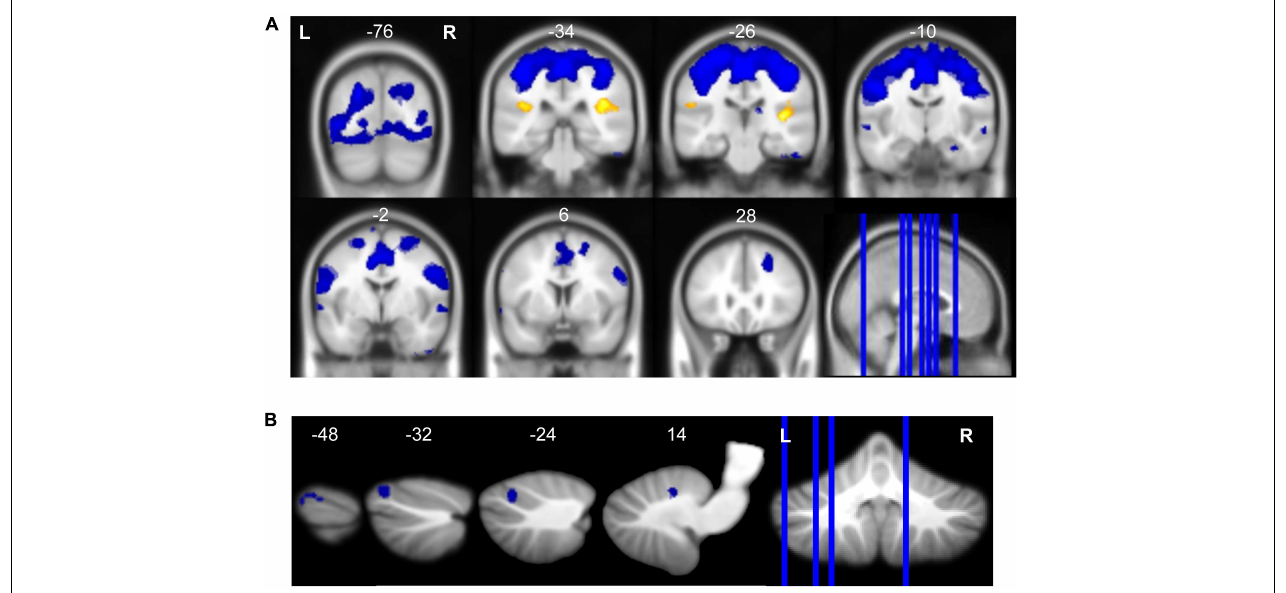
FIGURE 3 | Neural response to vestibular stimulation. Vestibular stimulation resulted in activation of insular cortex and widespread deactivation including (A) frontal, temporal, occipital, subcortical, and (B) cerebellar regions. Whole brain and cerebellar results are overlaid onto MNI (A) and SUIT (B) standard templates, respectively; p < 0.0005, k = 10; red = regions of activation; blue = regions of